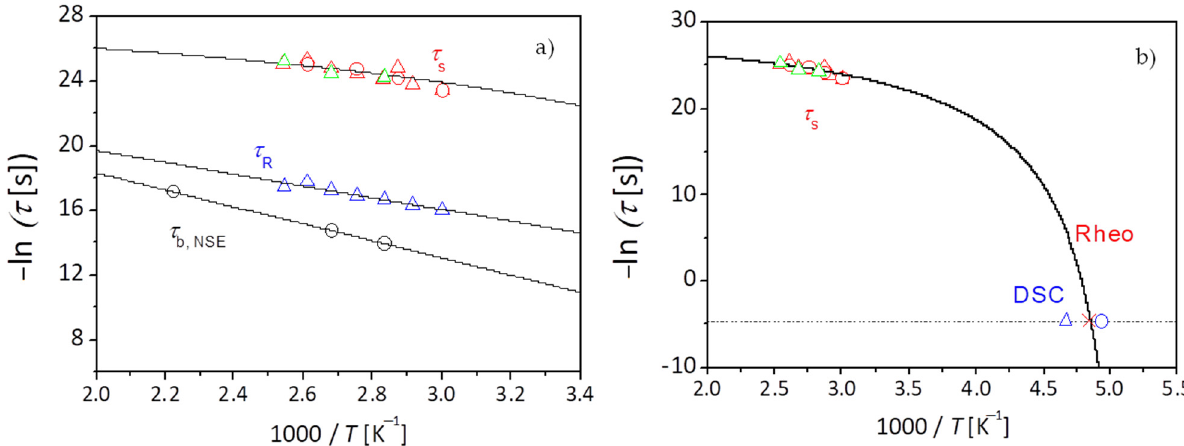
Figure 4. ( a ) Temperature dependence of relaxation times for supramolecular PEG-thy/dat (circles) and PEG polymer (triangles): blue—Rouse time τ R for PEG, red—segmental relaxation time τ s , green—segmental relaxation time from similar molar mass PEG polymer taken from literature [69], black— τ b,NSE bond breaking time obtained by NSE taken from literature for similar supramolecular PEG-thy/dat [18]. Black lines show the fit to the data using the Arrhenius equation for τ R and the Vogel-Fulcher-Tammann-Hess (VFTH) equation only for τ s data. ( b ) Temperature dependence of the segmental relaxation times for supramolecular PEG-thy/dat (circles) and PEG polymer (triangles) in comparison with the calorimetric glass transition obtained by DSC analysis. The dotted line corresponds to a τ = 100 s and the red cross indicates the T g obtained using the VFTH fit to the rheological segmental relaxation time data.